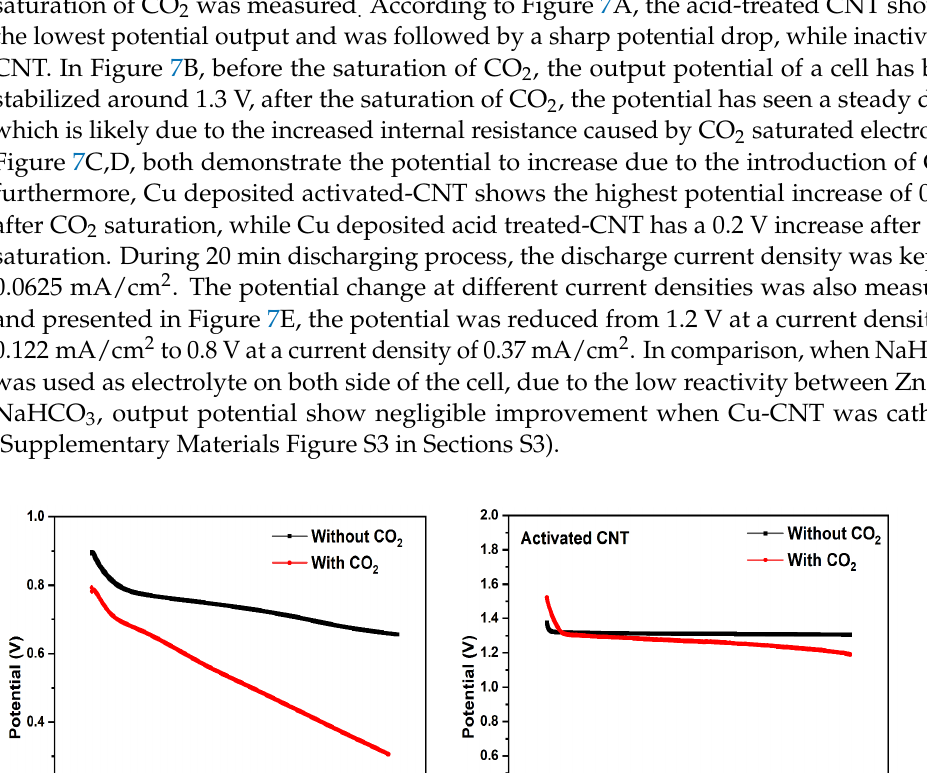
( D ) ( E ) Figure 7. Discharging curve of acid-treated CNT for 20 min ( A ), activated CNT ( B ), Cu-deposited acid-treated CNT ( C ), Cu deposited activated CNT ( D ), discharging curve of Cu deposited activated CNT at different current densities ( E ). According to various literature, pathways towards C2+ products are considered to be very complex and generates debate among researchers performing theoretical studies. Compared with C1 products, C2+ hydrocarbon by-products contain two or more carbon atoms and have higher energy densities, although most theoretically proposed mecha- nisms are based on density functional theory (DFT) simulations, however, the consensus